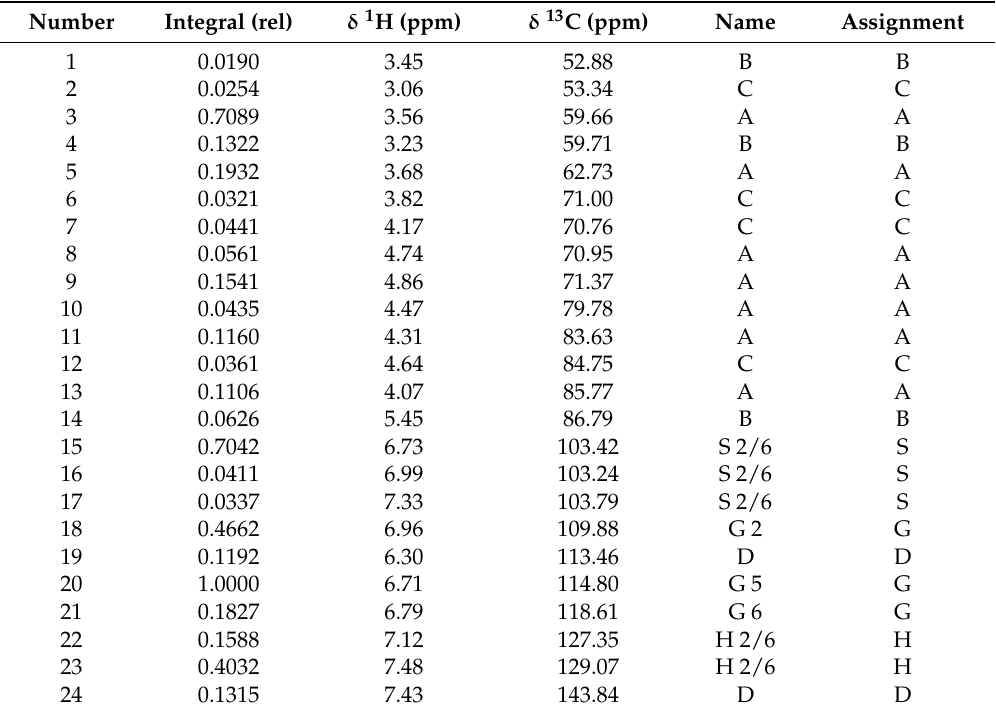
Table 8. HSQC 2D NMR data for an M . x giganteus stem/leaf mixture